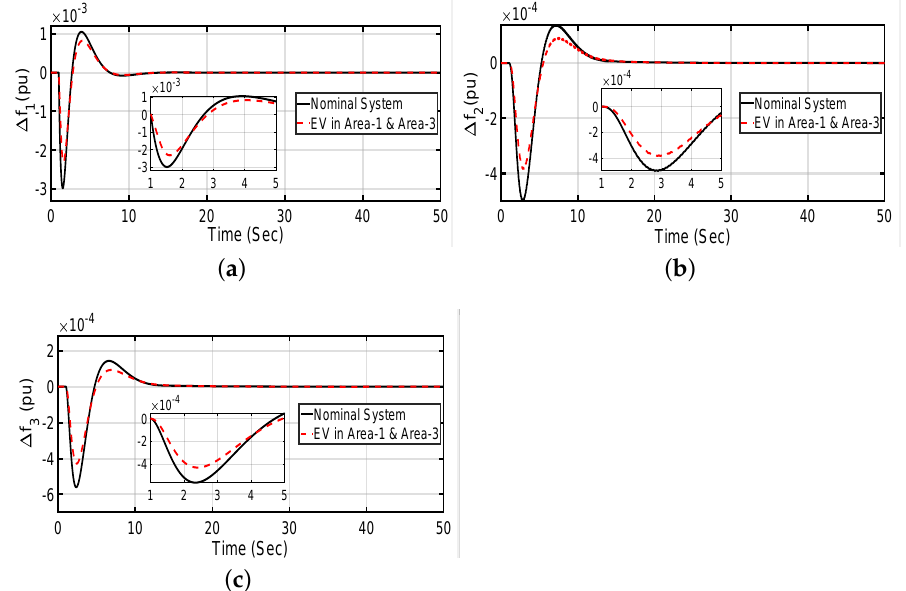
Figure 13. Response comparison when EVs are connected in Area 1 and Area 3 only. ( a ) ∆ f 1 ; ( b ) ∆ f 2 ; ( c ) ∆ f 3 .